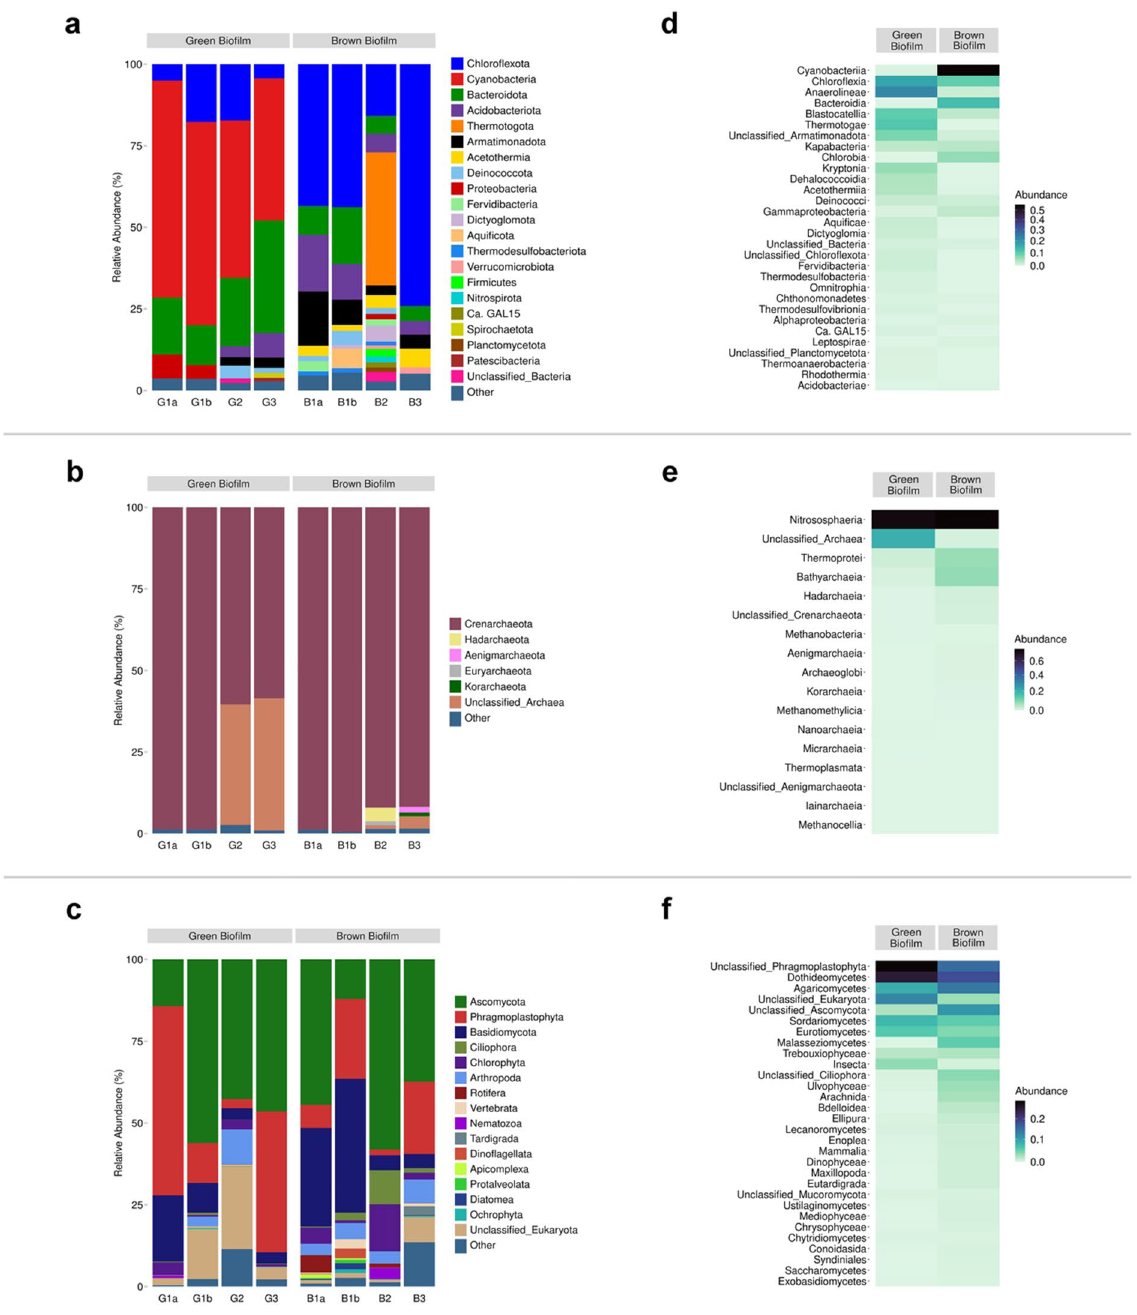
Figure 2. Taxonomic distribution at the phylum level of ( a ) Bacteria. ( b ) Archaea. ( c ) Eukaryotes. ( d – f ) Heat map showing the average relative abundance of class-taxonomy for green and brown mats, respectively for bacteria, archaea, and